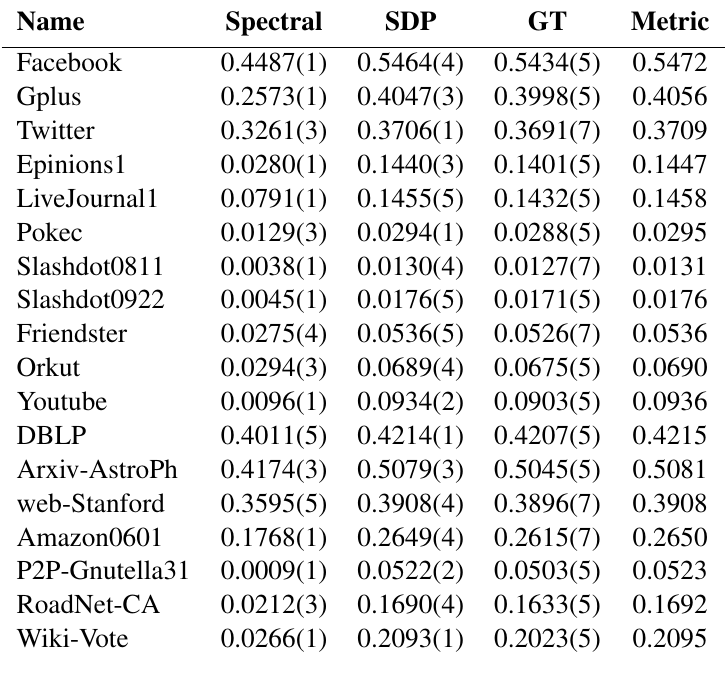
Table 4. Comparison of our approaches with other best methods in terms of modularity; the numbers inside the brackets denote the algorithm of the